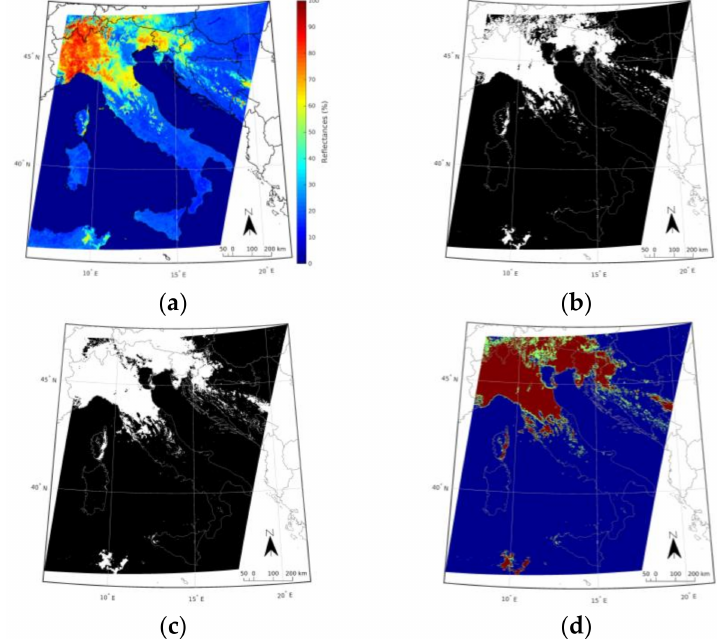
Figure 5. Images comparison between HRV LTTT Cloud Mask and MODIS MOD35 Cloud Mask. MODIS granule pass date 03.03.2017 09:50 UTC, MSG-SEVIRI image date 2017-03-03 09:45 UTC: ( a )